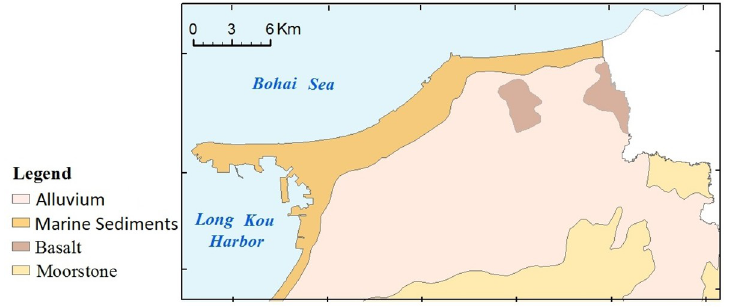
Fig 3. The maps of parent materials in the study area. (The parent materials map was generated using free, open access data sources from the Geological survey development research center of